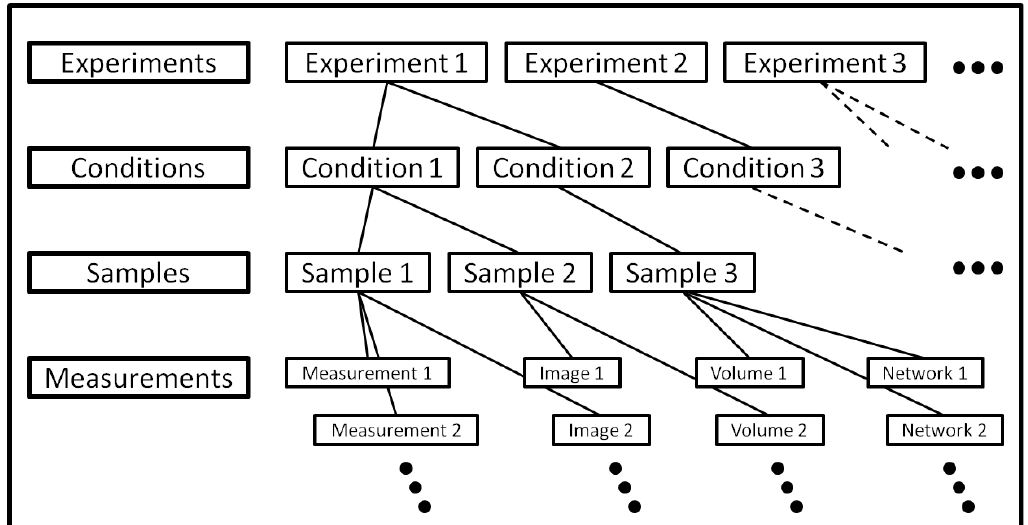
Figure 2: An experiment is a set of biological measurements together with it’s annotation data and is represented by a tree structure in four levels. It branches into a set of condition s which represent the treatment and the genotype of the examined species. Each condition forks into a set of sample s, which provide information about the underlying measured data. Measured data is allowed to exhibit the shape of decimal numbers, images, volumes, and biological